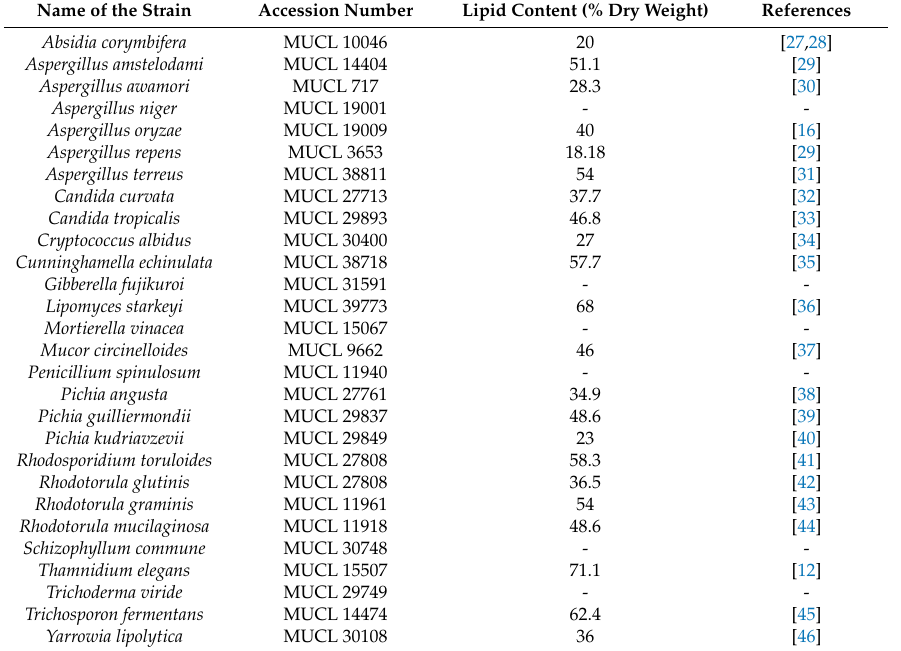
Table 1. Yeast and filamentous fungi strains used in this study and lipid contents described in literature (when